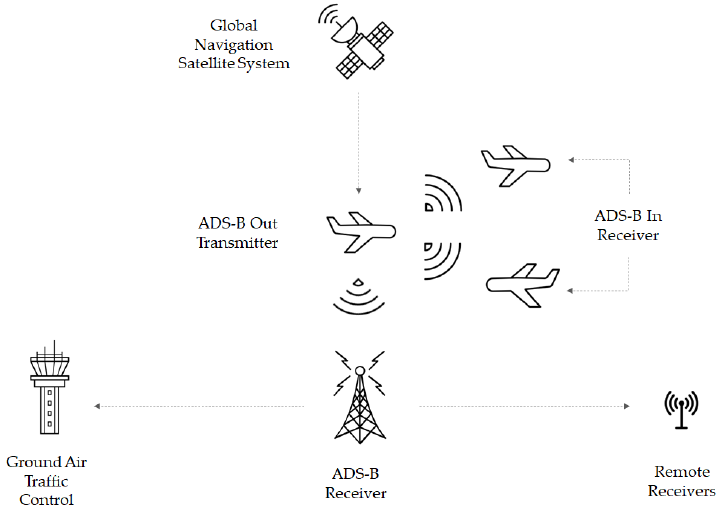
Figure 13. ADS–B operation diagram, derived from [20].